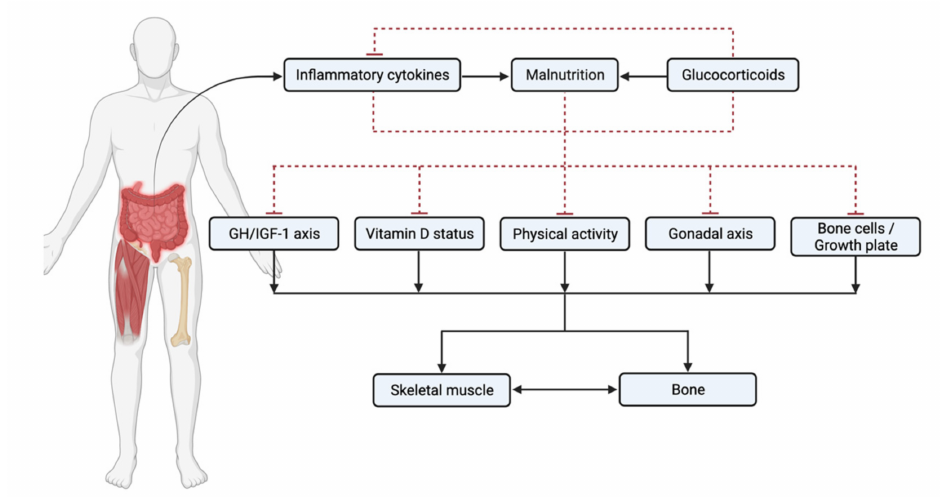
Figure 1. Factors associated with musculoskeletal deficits in children and adults with inflammatory bowel disease (IBD). Solid line = promoter; dashed line =